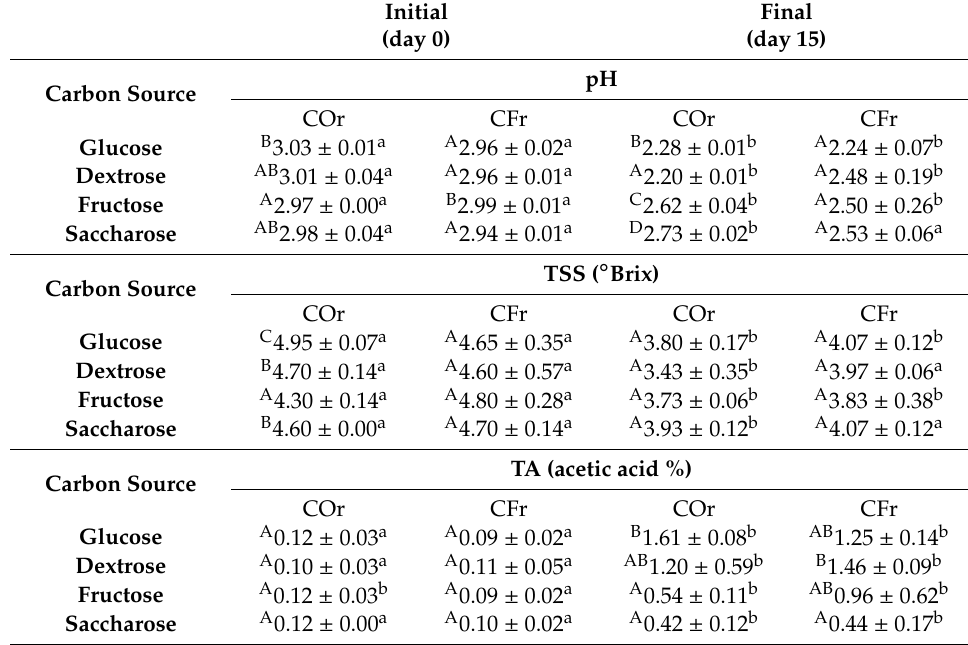
Table 1. Chemical composition of kombucha fermentations with various carbon sources stored at 25 ◦ C for 15